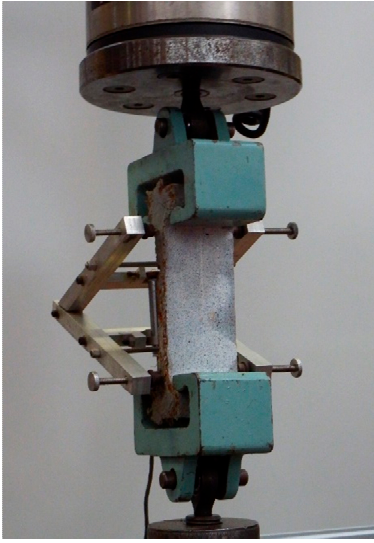
Figure 7. Direct tensile testing of UHPFRC-2 dog-bone specimens.